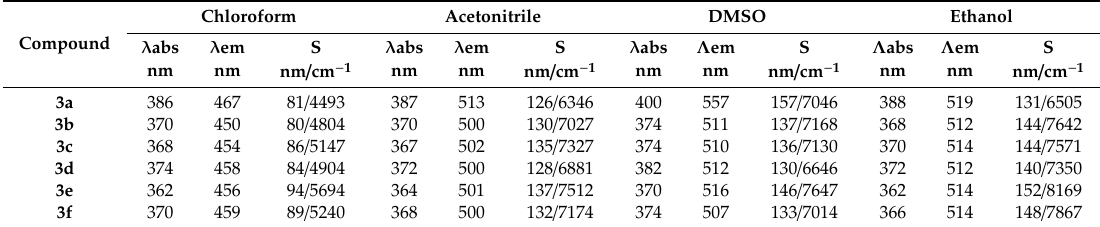
Table 2. Solvatochromic properties of the compounds 3a – f ; S–Stokes shift.